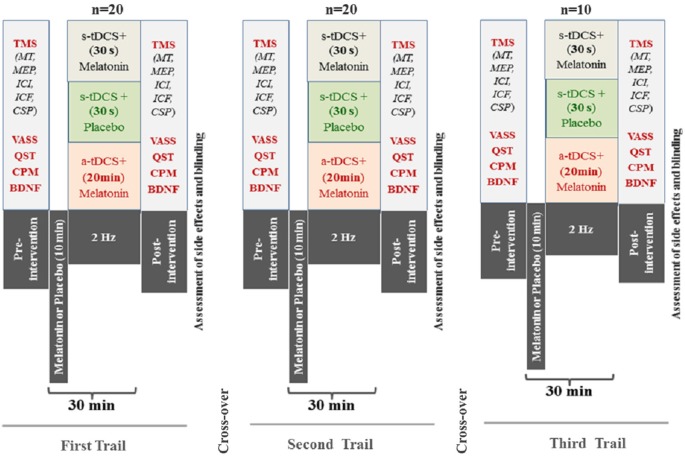
Experimental desing—Cross-over, assessements and interventions in each one of three sessions. The period between each session was 1 week. (Motor evoked potential: MEP); Intra-cortical inhibition (ICI) expresses the relationship between the amplitude of wave and motor evoked potentials (relative amplitude, express in %), at inter-stimuli intervals (ISIs) of 2 ms with paired-pulse. The first is a sub-threshold stimulus [80% of the rest motor threshold (rMT)] followed by the second one which is a suprathreshold stimulus (130% rMT). Cortical silent period (CSP) expressed in milliseconds (ms); Motor-evoked potentials (MEP) expressed in mV, evoked by a stimulus of 130% the intensity of the rMT, and should have peak-to-peak MEP amplitude of at least 1 mV. Conditioned Pain Modulation (CPM); Visual Analogue Sleepiness Scale (VASS); Brain Deriavete Neural Factor (BDNF).